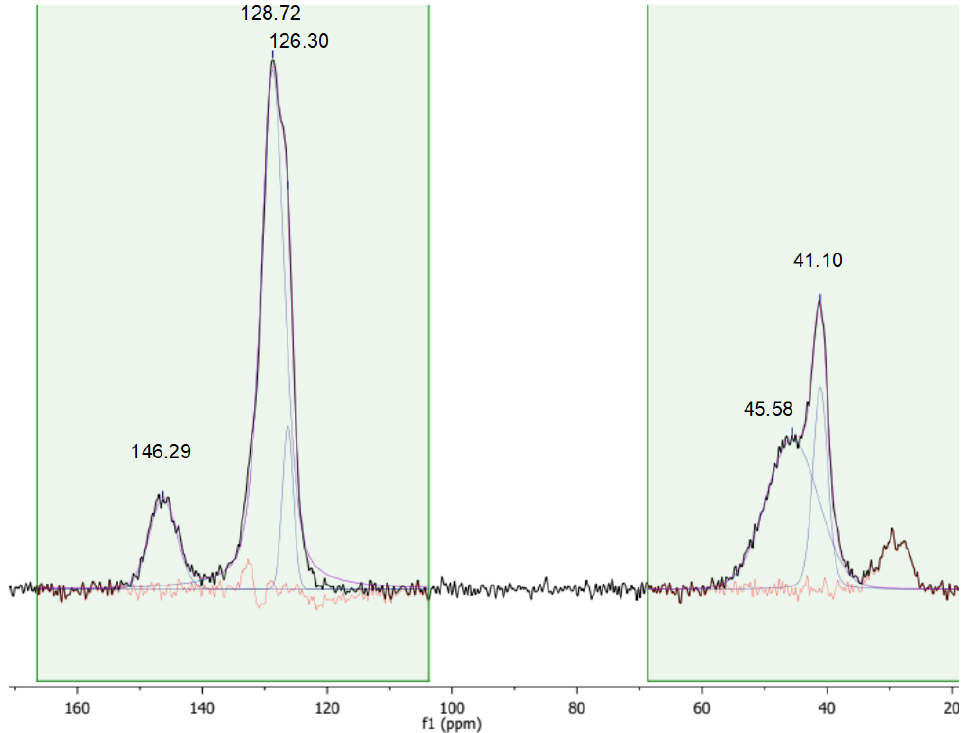
Figure 8. 1 H 13 C MAS spectrum of the starting gel-type poly(styrene-divinylbenzene) (2% mol DVB). Contact time 1 ms, MAS rate = 10 kHz, T = 25 °C.